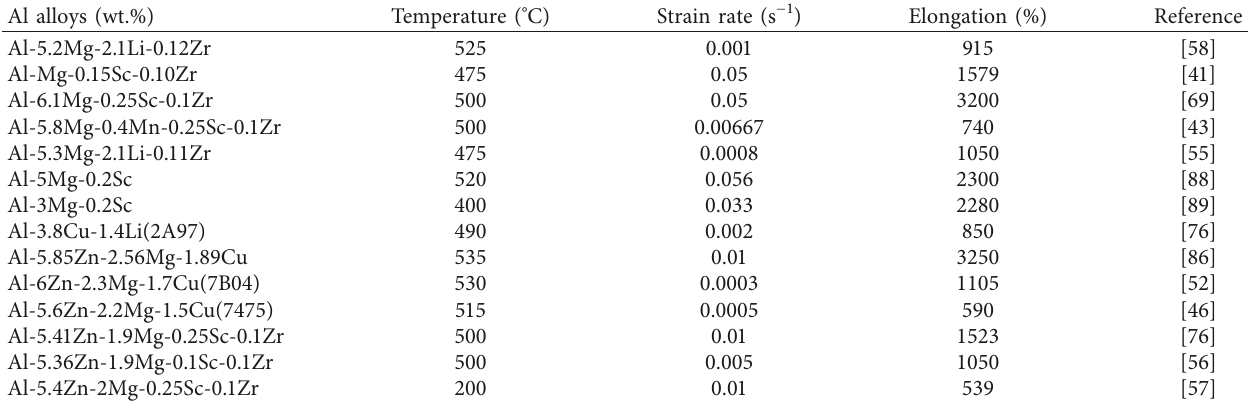
Table 3: Deformation conditions of optimal superplastic elongation of Al alloys.